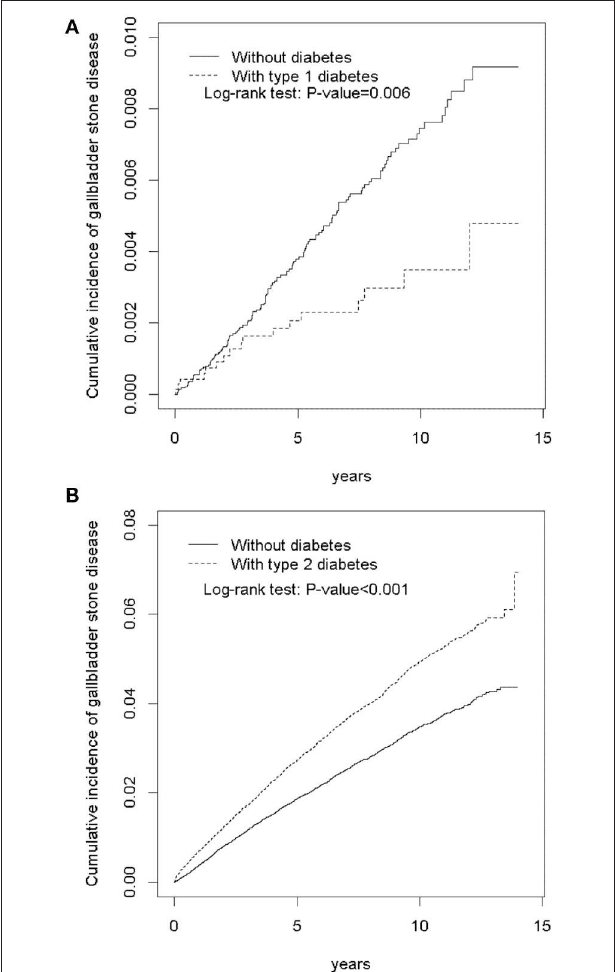
FIGURE 2 | Cumulative incidence of gallbladder stone disease between patients with type 1 diabetes (A) and patients with type 2 diabetes (B) , and without